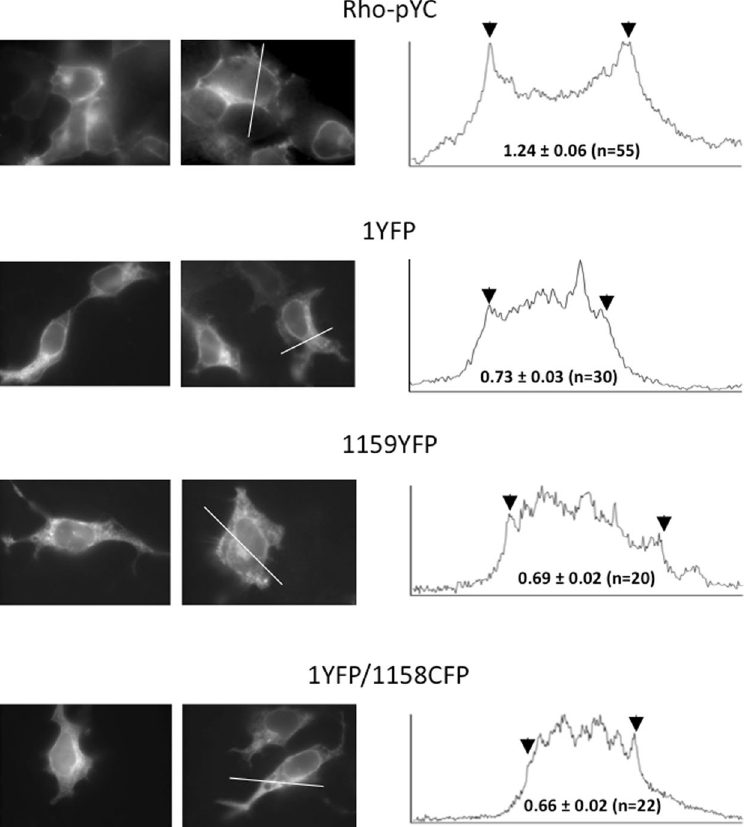
Figure 5. Cellular localization of hERG fluorescent fusion proteins carrying amino and carboxy terminal attached FPs. Representative cells expressing hERG-labeled channels with YFP at position 1 or 1159 or double- labeled 1YFP/1158CFP as indicated, and imaged by epifluorescence microscopy as described in Methods, are shown on the left. The top row corresponds to cells expressing the CFP-YFP Rho-pYC tandem. Fluorescence intensity profiles along the depicted white line are shown on the right. Arrows indicate the position of the fluorescence signal corresponding to the plasma membrane contour. Numbers in the profile panels indicate the values of the fluorescence intensity ratios obtained dividing the averaged fluorescence of the image pixels corresponding to a line traced on top of the cell edge (see Suppl. Fig. 2 for details) by the averaged fluorescence in the internal cell